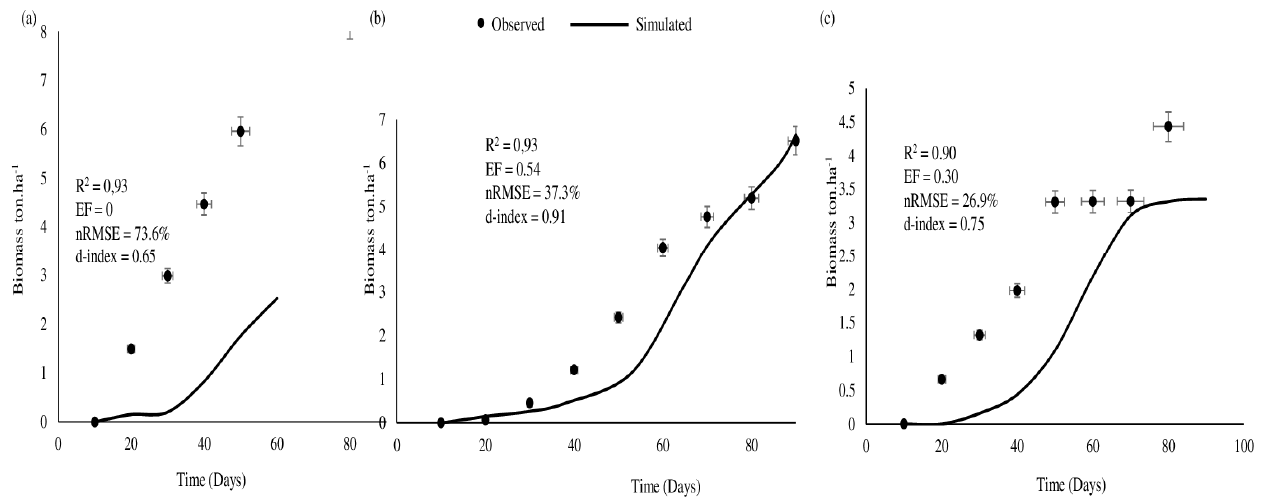
Figure 5. Observed and simulated biomass ( B ) under ( a ) 100% ET c , ( b ) 75% ET c , and ( c ) 55% ET c irrigation regimes. The model over-estimated yield simulations despite having simulated CC well. Yield Table 8. Observed and simulated yield and final biomass during